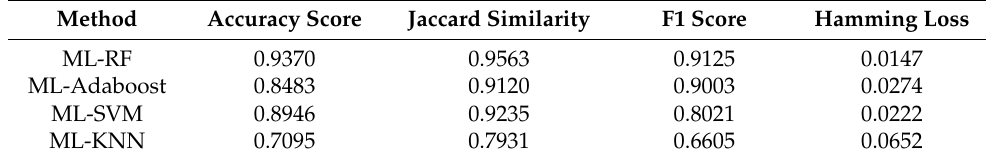
Table 3. Scenario 2: comparison with other